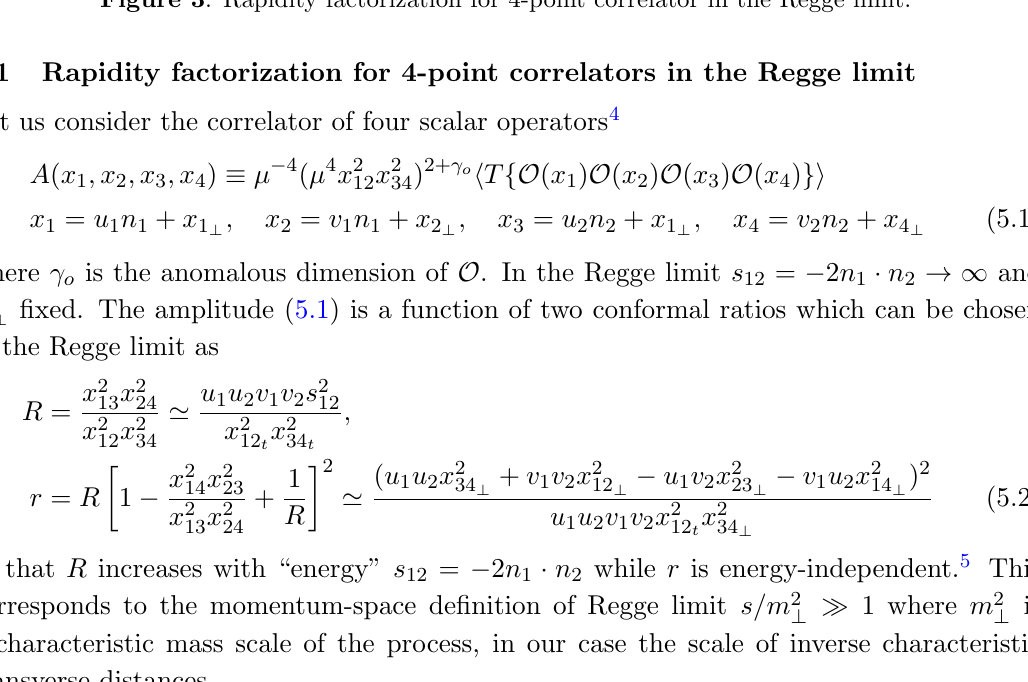
Figure 3 . Rapidity factorization for 4-point correlator in the Regge